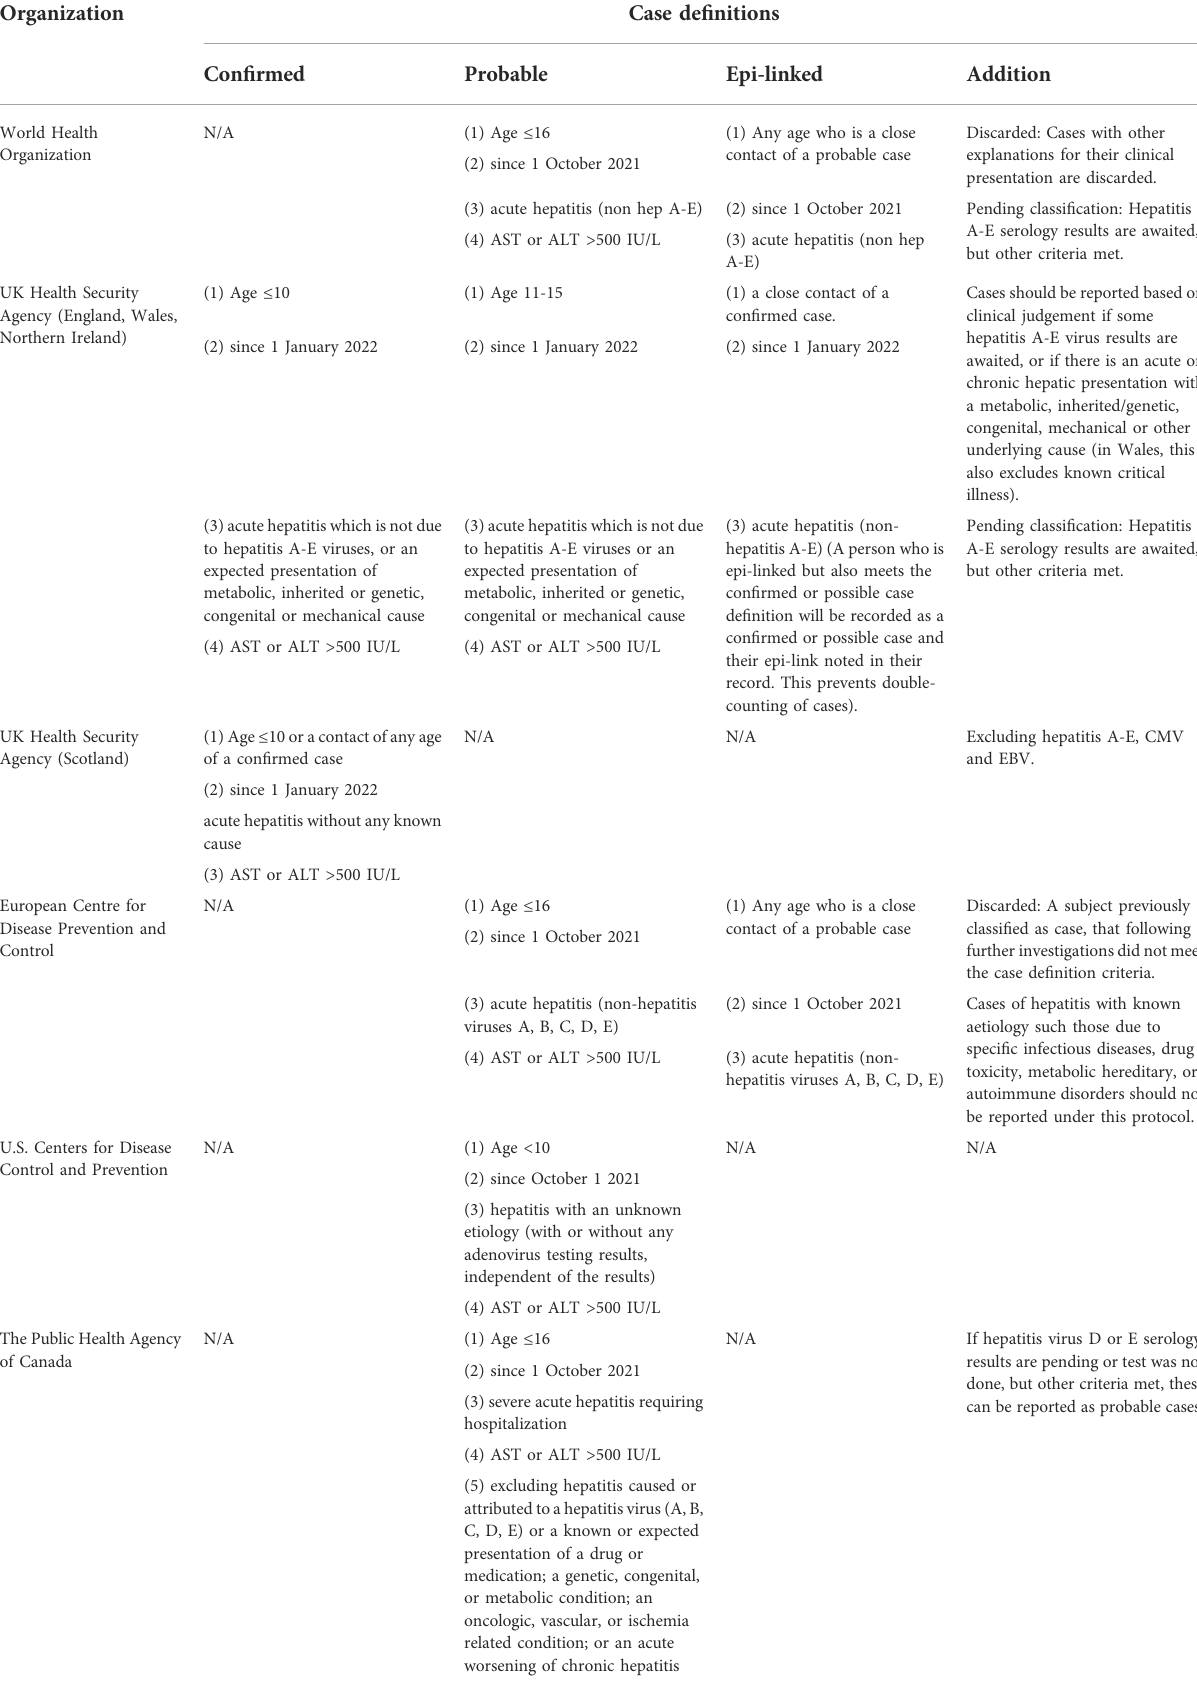
TABLE 2 The different case de fi nitions in the different